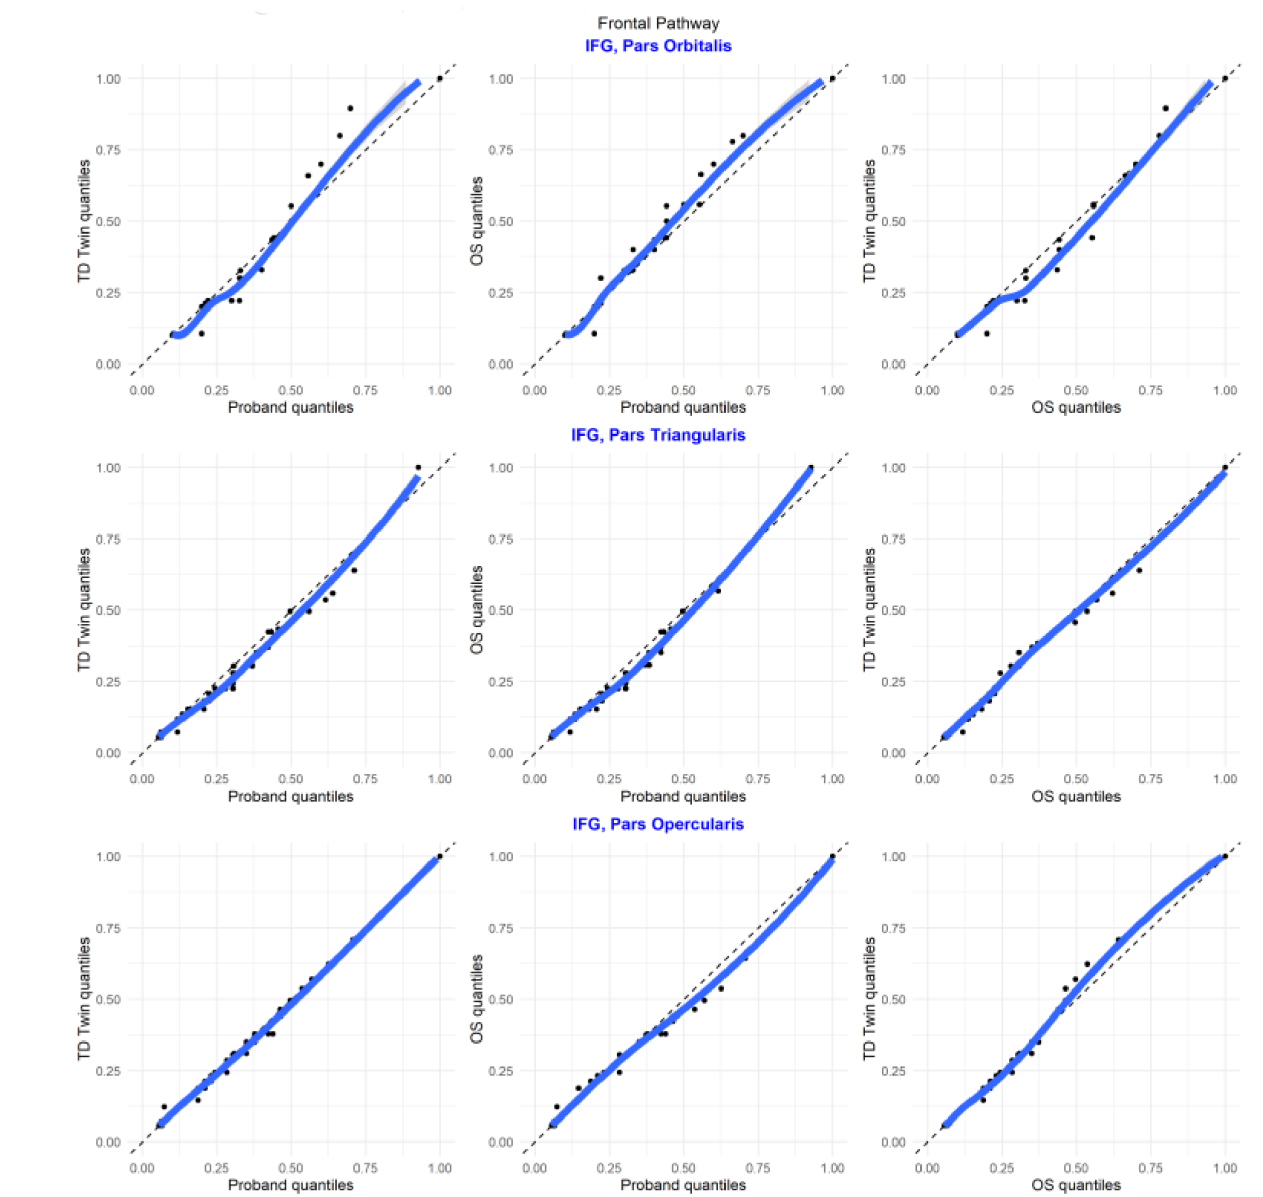
Figure 10. Q–Q plots of sibling comparisons of regions in the frontal pathway. In the plots comparing regions of interest within each individual, for many of the comparisons, the relationships between structures were similar for each of the twins (in the supmarginal/angular, supramarginal/transverse temporal, supramarginal/planum tem- porale, angular/superior temporal, angular/planum temporale, angular/planum polare, superior temporal/planum temporale, superior temporal/planum polare, transverse tem- poral/planum temporale, transverse temporal/planum polare, planum temporale/planum polare pairs). For the superior temporal/transverse temporal comparison, superior tem- poral/supramarginal, and angular/transverse temporal comparison, the siblings with reading disability tended to be more similar (Figure